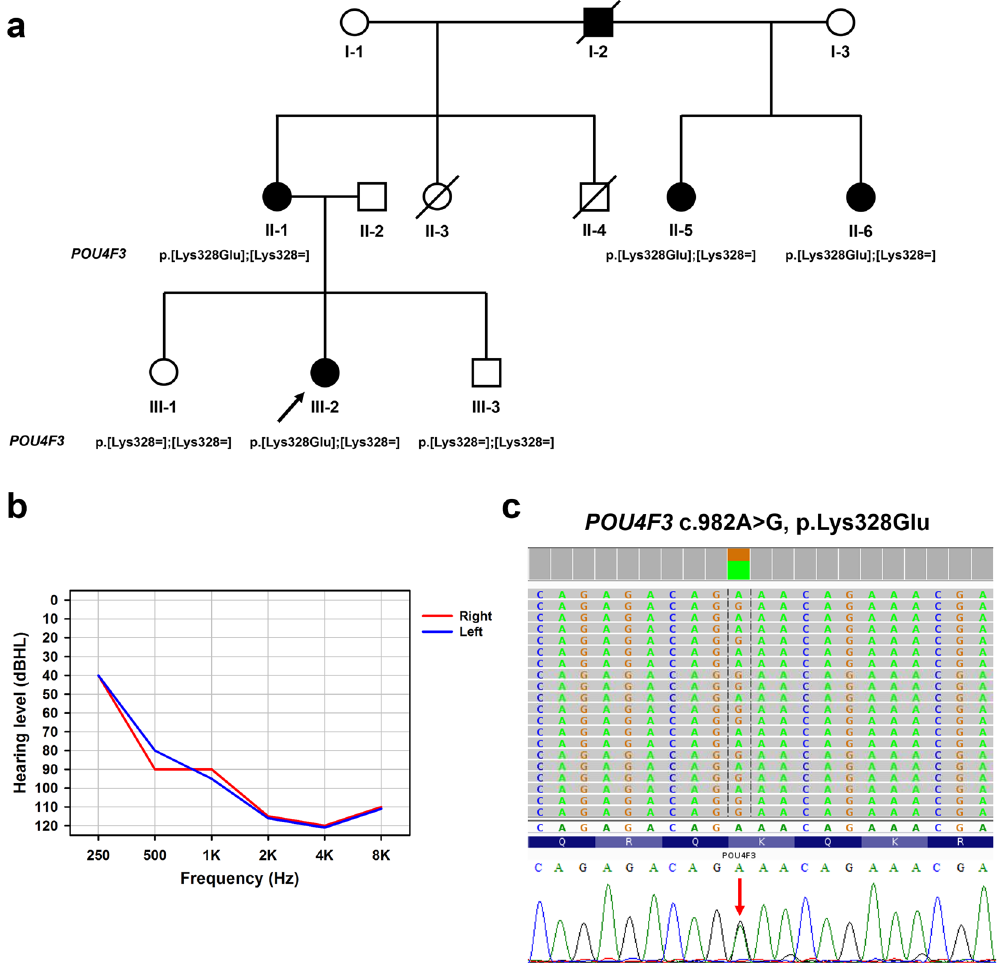
Figure 1. ( a ) The pedigree and segregation pattern of the family, which harbored POU4F3 p.Lys328Glu. ( b ) The audiogram of both ears in the proband of the family revealed profound hearing loss with down-sloping shape. Hearing levels of the right and the left ear are marked using red and blue lines, respectively. ( c ) MPS-based panel identified a POU4F3 c.982A > G, p.Lys328Glu variant in the proband and this variant was validated by Sanger